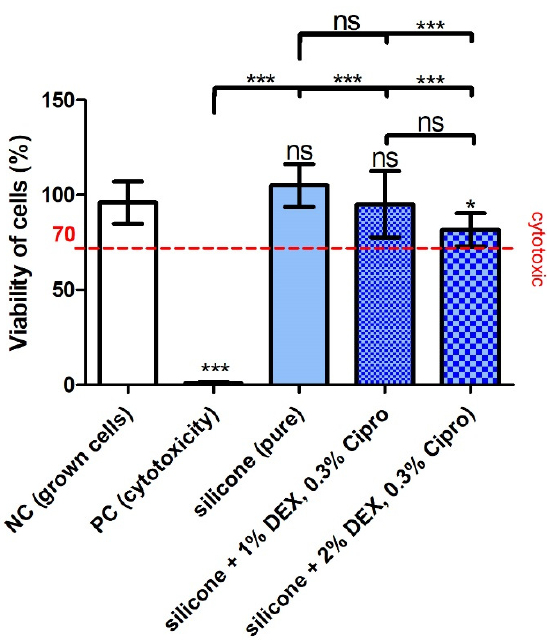
Figure 3. Cell viability results of fibroblasts treated with the supernatant of the different conditions. The positive control (PC) showed a massive and significant reduction of cell viability compared to the NC and silicone groups, indicating the cytotoxic effect of DMSO and proving that the test was appropriately performed. There were no significant differences detectable between the negative control (NC) and the silicone groups except for silicone with 2% dexamethasone (DEX). This higher amount of included DEX also reduced the cell viability compared to pure silicone, while this was not the case for 1% DEX. A viability of 70% (red line) is labeled to mark the cut-off for the cytotoxic effect of materials (ISO 10993-5:2009). Only the PC showed a cell viability below this mark. Data are given as mean ± standard deviation (SD) and significances are labeled with *** p < 0.001, * p < 0.05, and ns: not significant. Significances marked above the error bar refer to the NC. N = 1; n = 3 (NC, PC), n = 9 (silicone, silicone DEX 1%, cipro 0.3%, silicone DEX 2%, cipro 0.3%).